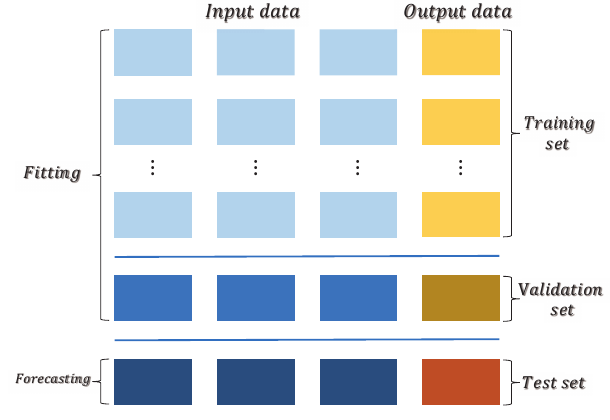
Figure 2. The “hold-out”